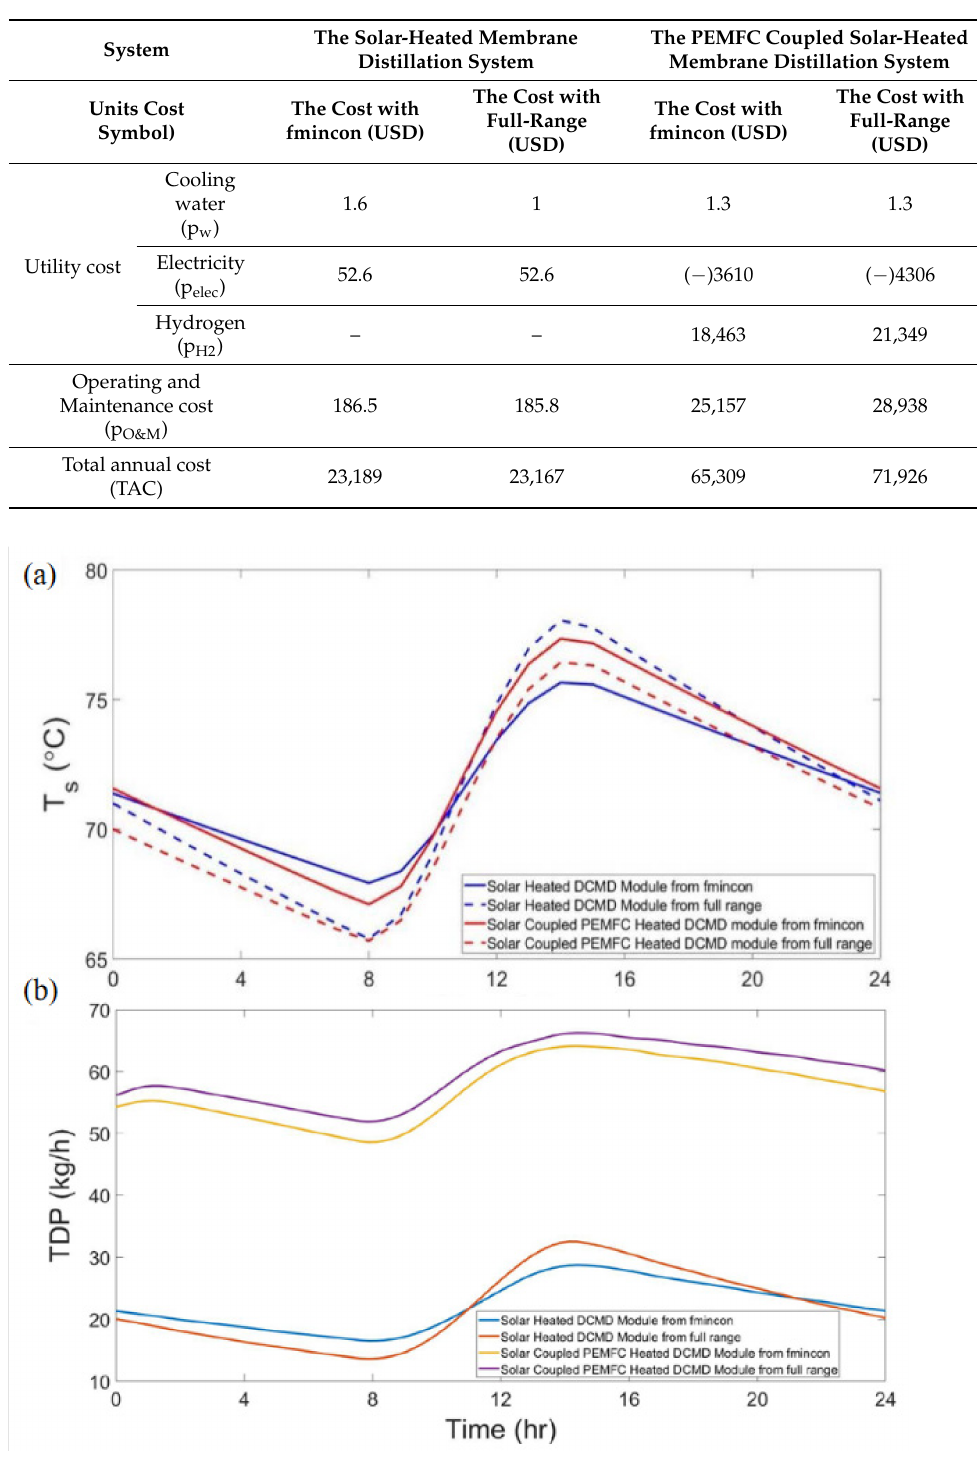
Figure 12. ( a ). The heat storage tank temperature of both systems and ( b ) the daily water production profile with different